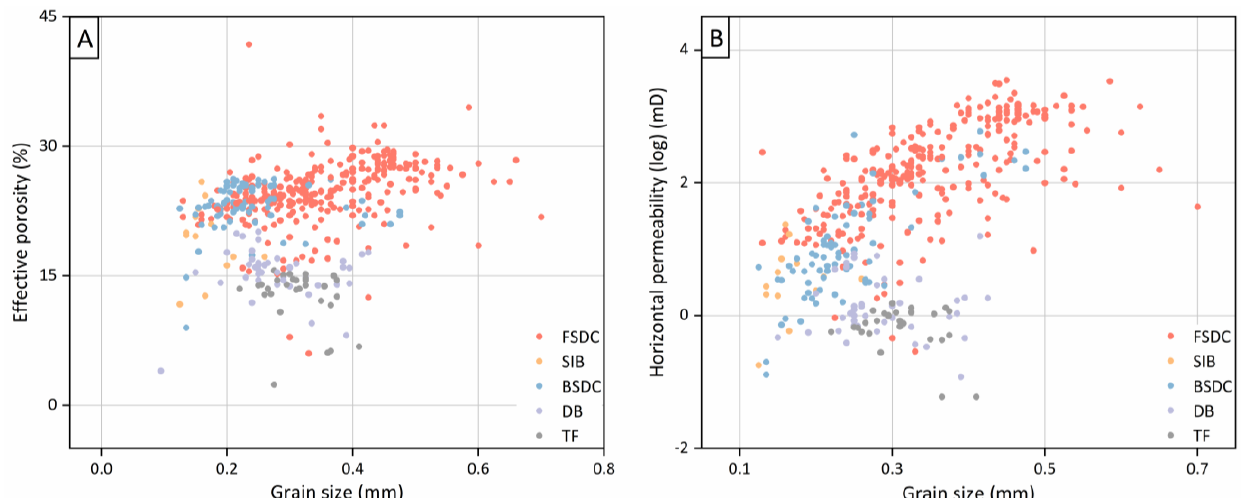
Figure 10. Plots of reservoir properties versus grain size derived from point count, split by different sedimentary microfacies. ( A ) Core effective porosity versus grain size; ( B ) Core horizontal permea- bility versus grain size. (FSDC — submerged distributary channel (fan delta), SIB — submerged inter- distributary bay, BSDC — submerged distributary channels (braided delta), DB — distal bar, TF — tur- bidite fan).